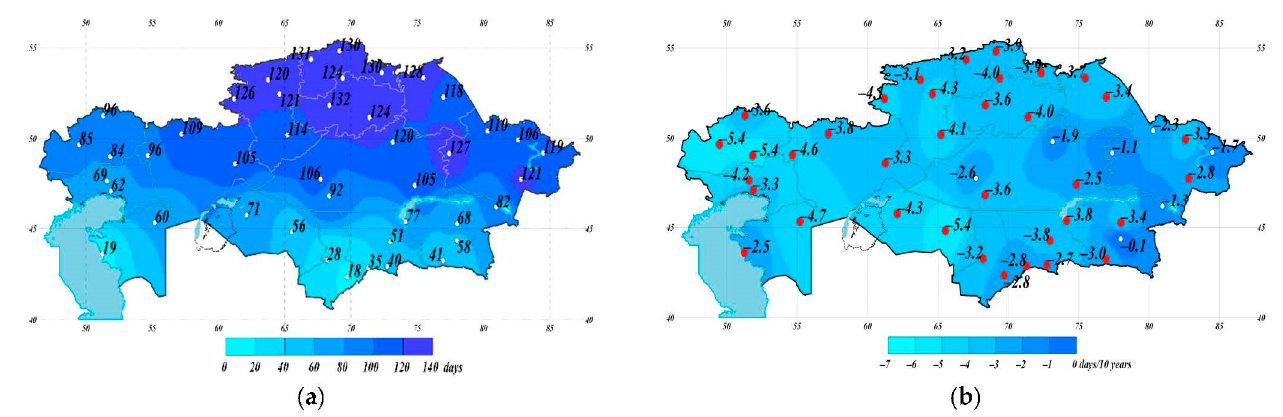
Figure 3. The spatial distribution of the index is the number of days of daily temperature maxima below zero degrees (ID) ( a ) and trends ( b ) of this parameter for the period 1971–2020. The number of days with a maximum daily temperature of < 25 ◦ C (SU) is characteristic of the warm season and has the opposite distribution to FD (Figure 4). The SU change range is 51–76 days in northern Kazakhstan and 134–157 days in southwestern and southern Kazakhstan. In the latitudinal zone from 49 ◦ to 52 ◦ N, average SU values are observed and are 103–122 days. The maps also show latitudinal zonality disturbed by the influence of the Caspian Sea.